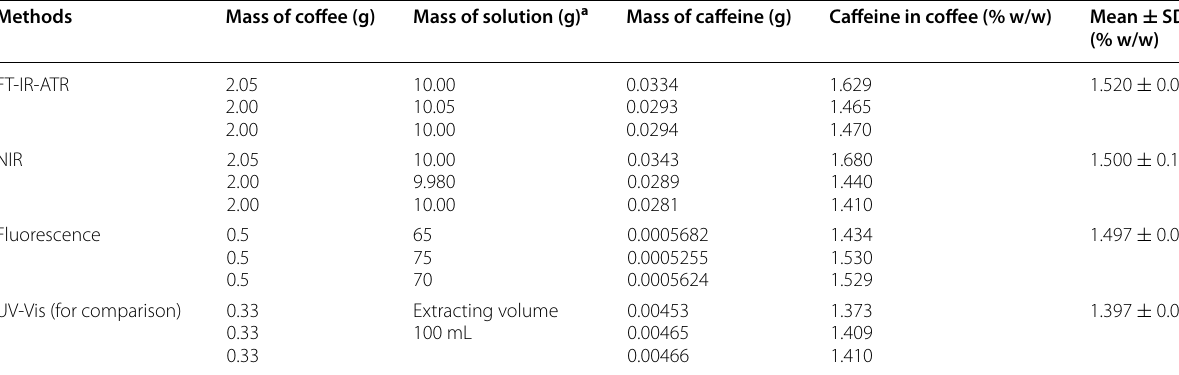
Table 1 The mean percentage of caffeine obtained by the three methods